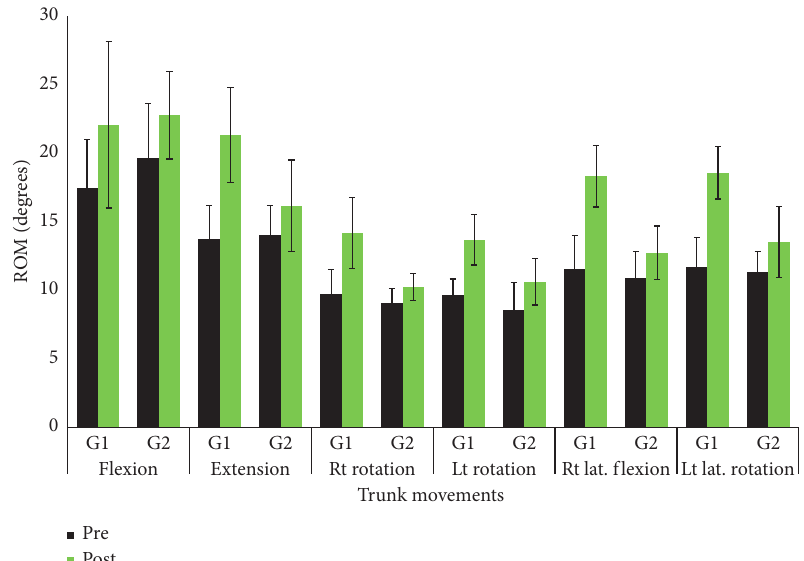
Figure 4: Within and in-between group comparison of the mean ± standard deviations (SD) of pre- and posttreatment measures of the trunk range of